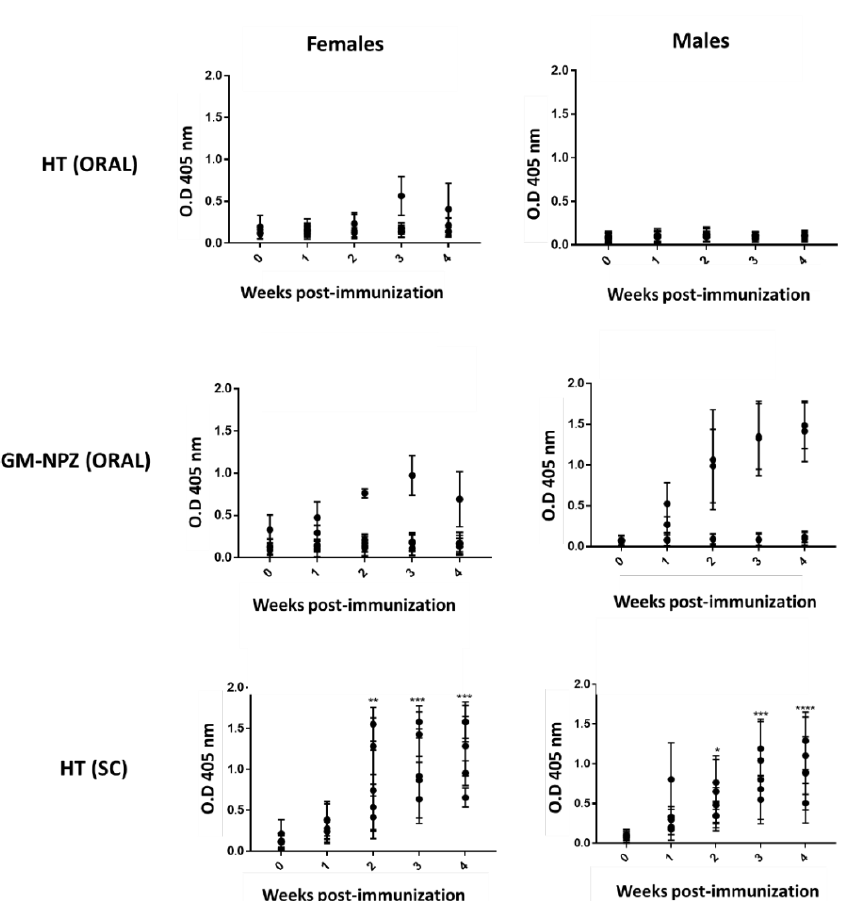
Figure 6. Antibody immune response induced after oral or subcutaneous (SC) vaccination of BALB/c mice with free outer membrane vesicles (OMV) or OMV encapsulated into zein nanoparticles coated with Gantrez ® (GM-NPZ). Specific serum IgG2a against OMV in immunized BALB/c mice with 100 µ g of OMV or 16 mg of OMV-GM-NPZ taken from week 0 to 4 week after immunization. (* p < 0.05; ** p < 0.01; *** p < 0.001; **** p < 0.0001; vs. pre-immunization time). Error bars represent SD.